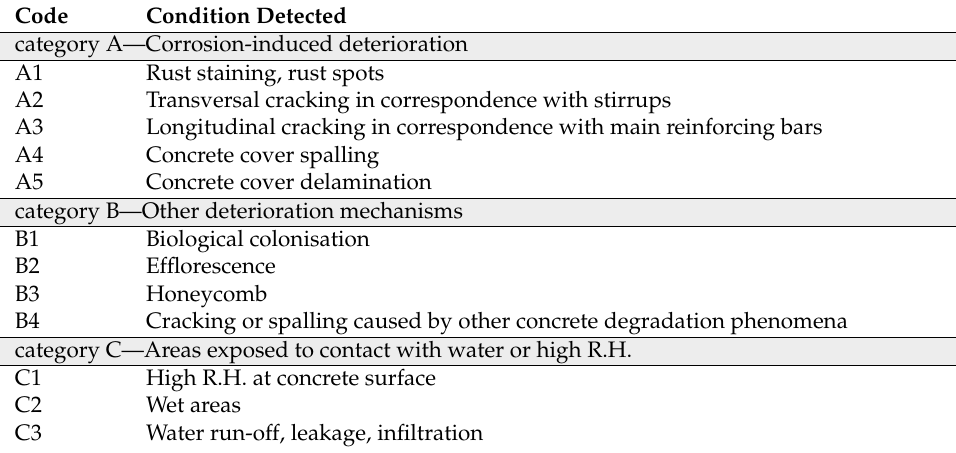
Table 2. Abacus of the possible visible deterioration conditions.